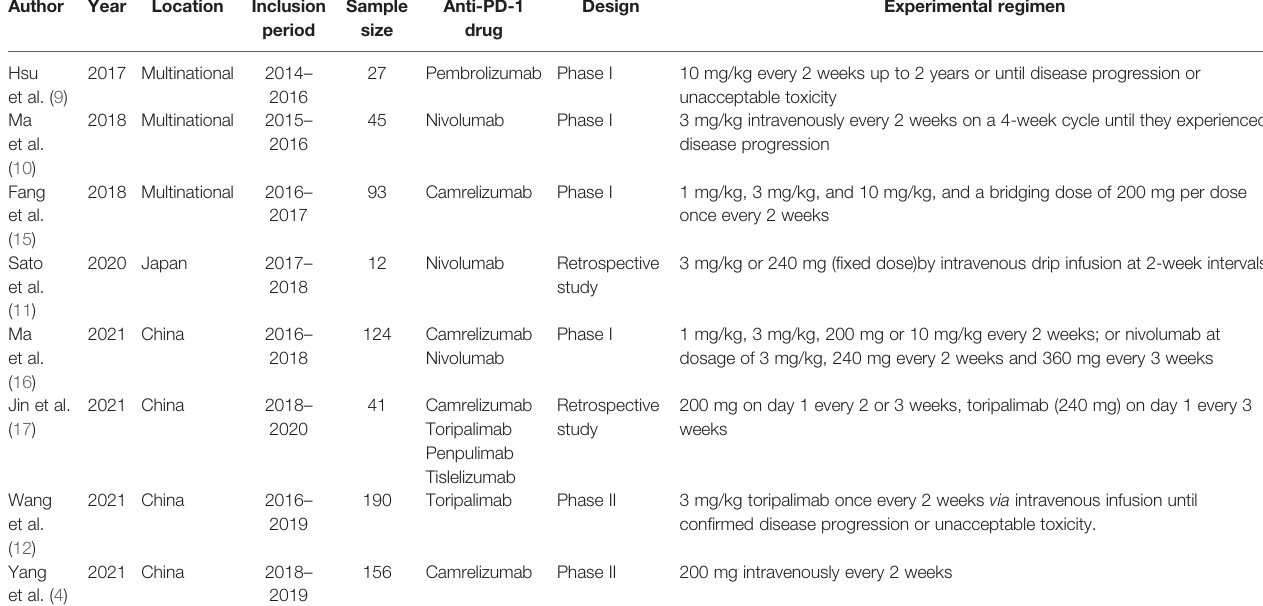
TABLE 2 | Characteristics of included studies.